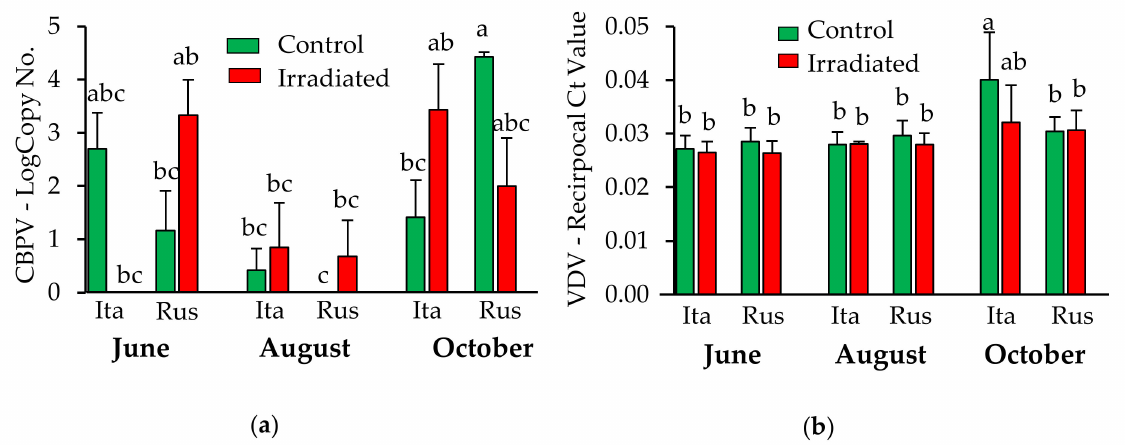
Figure 4. Wax-borne levels (mean ± SE) of ( a ) Chronic bee paralysis virus (CBPV) and ( b ) Varroa destructor virus-1 (VDV-1) in Italian and Russian honey bee colonies having irradiated or non-irradiated (control) combs across the season. Bars with the same letters are not significantly different ( p > 0.05). Ita = Italian; Rus =